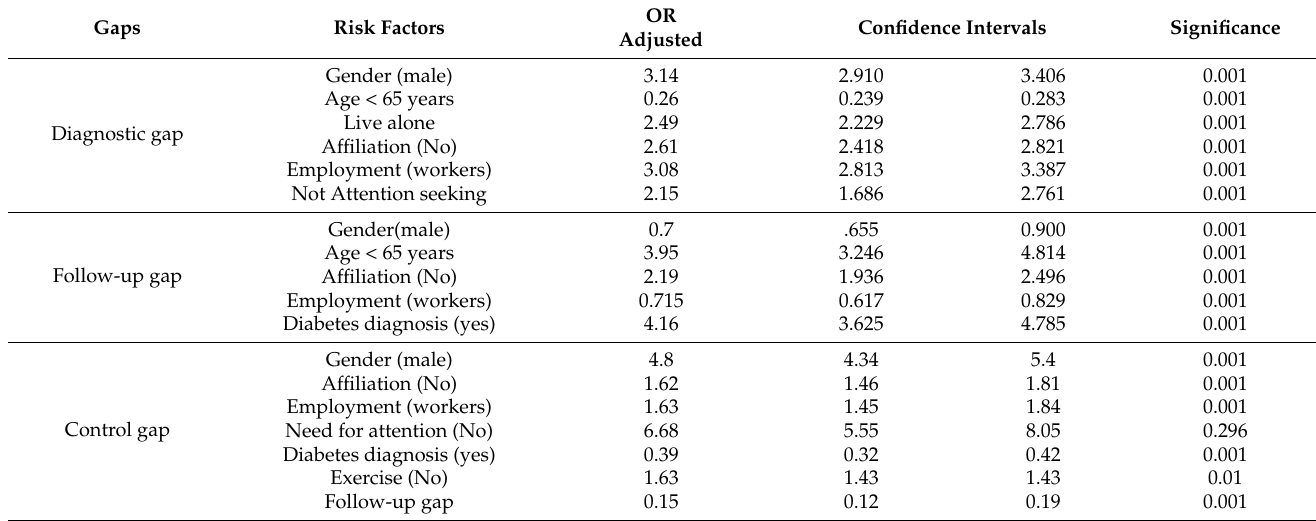
Table 5. Logistic regression model of risk factors for gaps in diagnosis, monitoring and control of